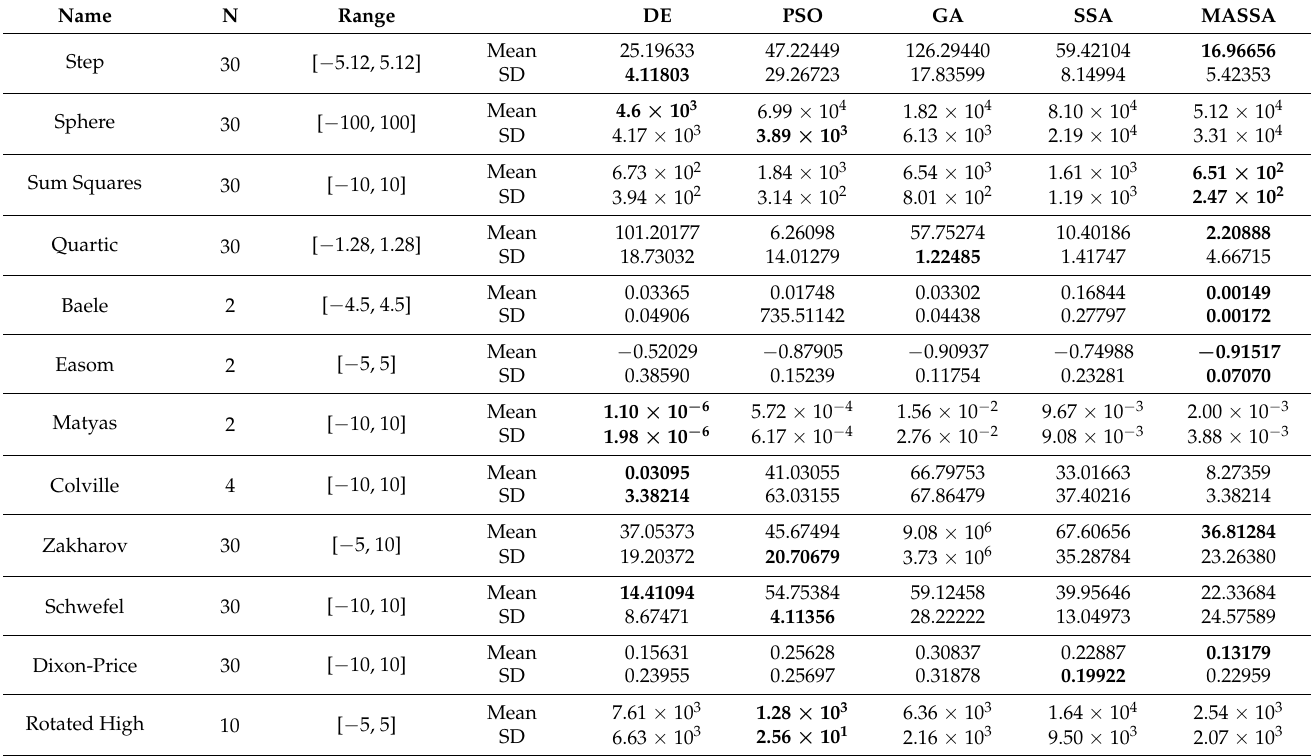
Table 5. Result of unimodal benchmark functions.